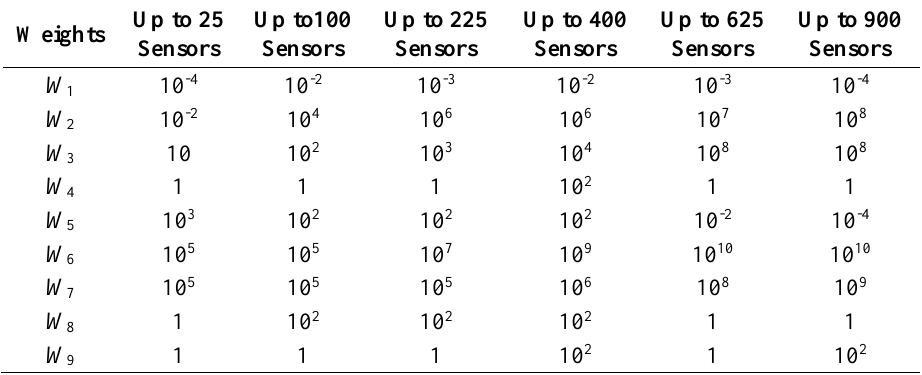
Table 6. Weighing coefficient of fitness function for constant mutation